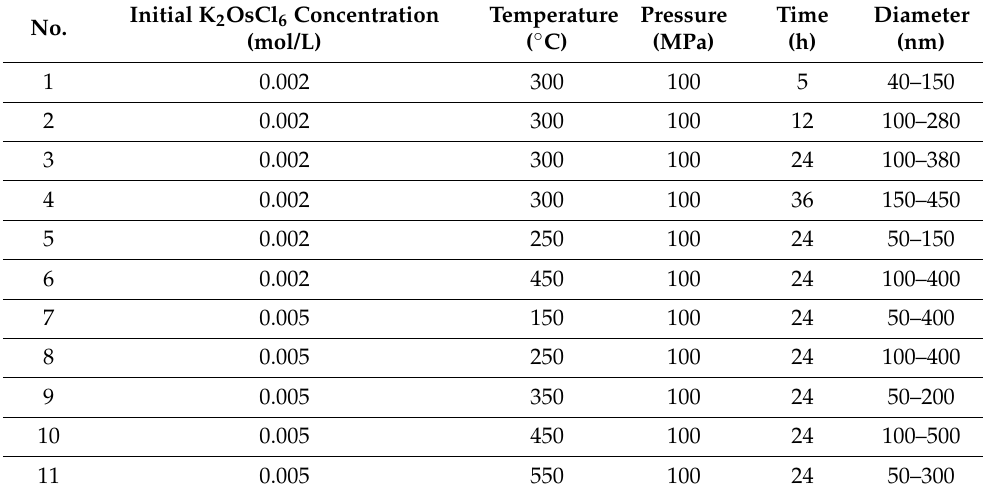
Table 1. Preparation of the OsO 2 nanospheres under various